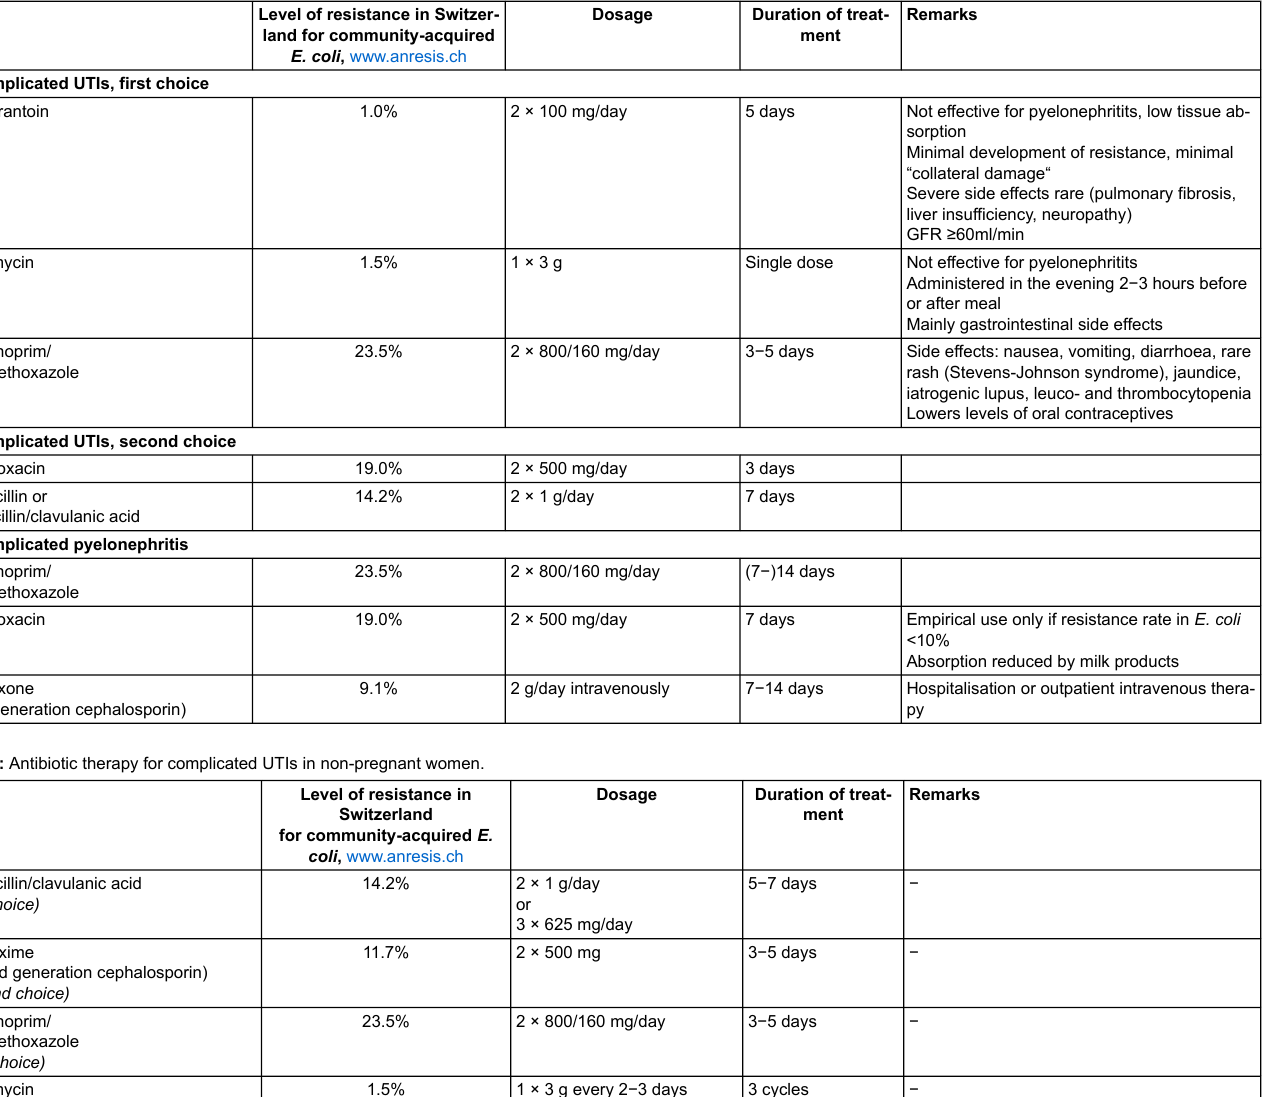
Table 3: Antibiotic therapy for uncomplicated UTIs and pyelonephritis in non-pregnant women. Level of resistance in Switzer- land for community-acquired E. coli , www.anresis.ch